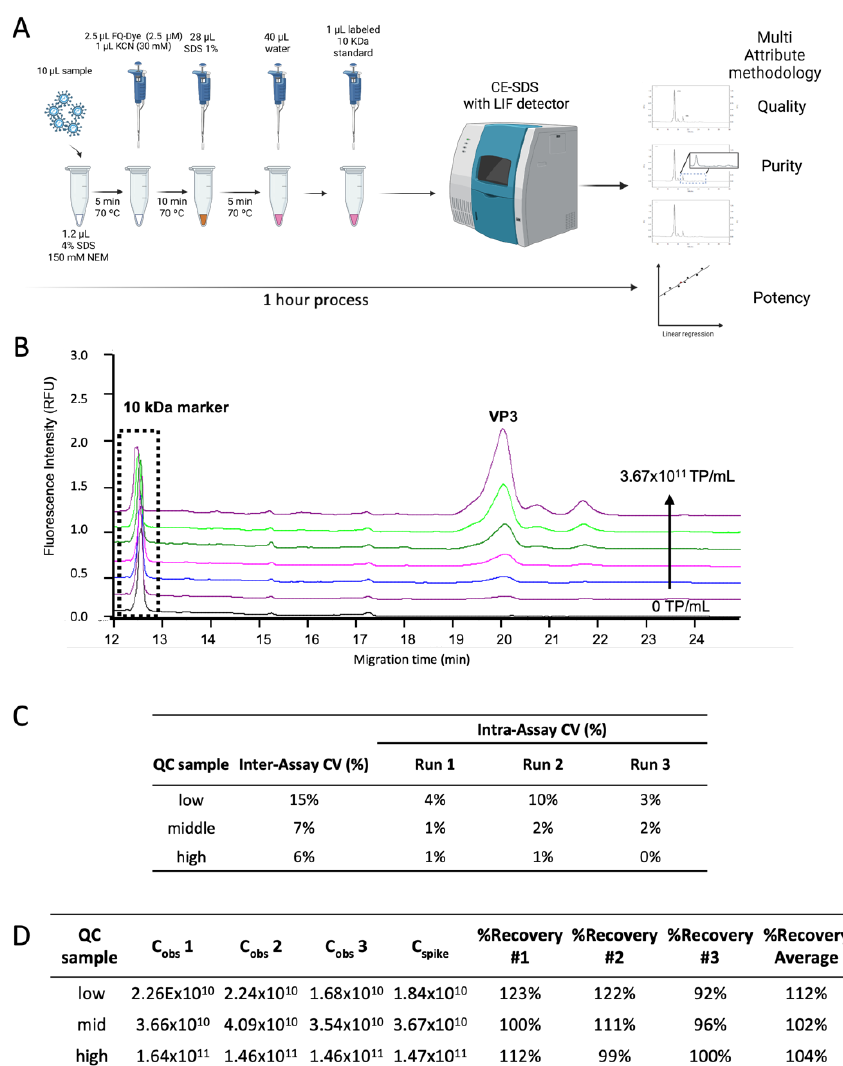
Figure 6. Applicability of the CE-SDS LIF as a quantification method for viral-based manufacturing. ( A ) Schematic representation of the workflow performed for quantification approach. ( B ) Overlay of the electropherograms of the standard calibration curve from 0 to 3.67 × 10 11 TP/mL. ( C ) Intermediate precision determination, comparison between the calculated quality control (QC) samples concentra- tion with the theoretical concentration (1.84 × 10 10 , 3.67 × 10 10 , 1.47 × 10 11 TP/mL). ( D ) Accuracy results for the 3 QC samples of reference standard AAV2: low, mid, and high range. The recovery (%) was calculated by the C obs to C spike ratio for each run multiplied by 100. C obs —extrapolated concen- tration of QC samples from the calibration curve; C spike —theoretical concentration of QC